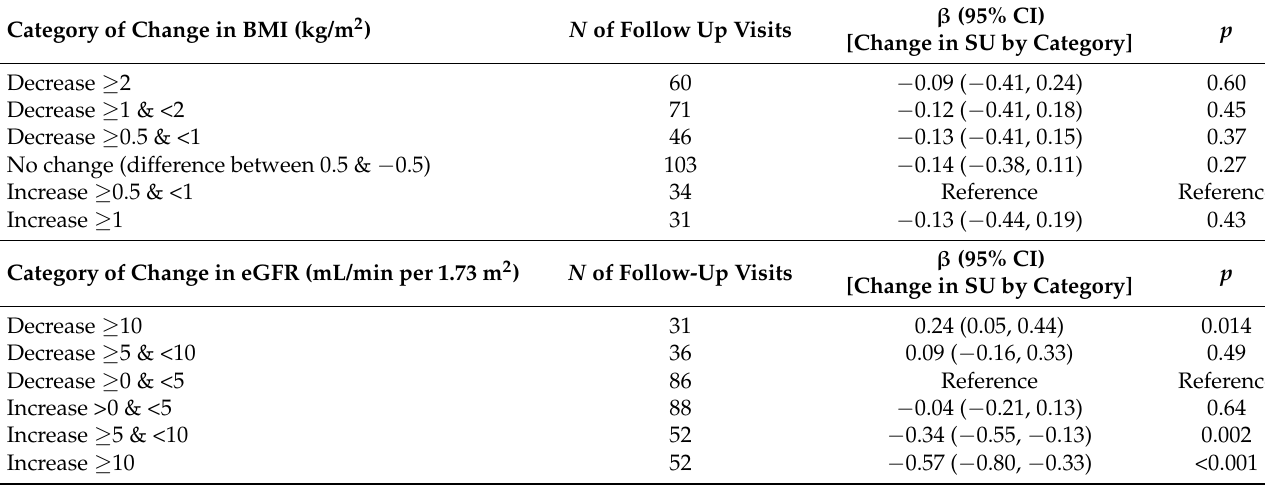
Table 4. (Top) Cross-sectional association of category of body mass index (BMI) change from baseline with serum urate (SU) change from baseline. N = 118 participants with 345 follow-up visits (Bottom) Cross-sectional association of category of estimated glomerular filtration rate (eGFR) change from baseline with SU change from baseline. N = 118 participants with 345 follow-up visits. The referent group was based on where the observed peak for BMI or a mid-point for eGFR. These comparisons were performed using generalized estimating